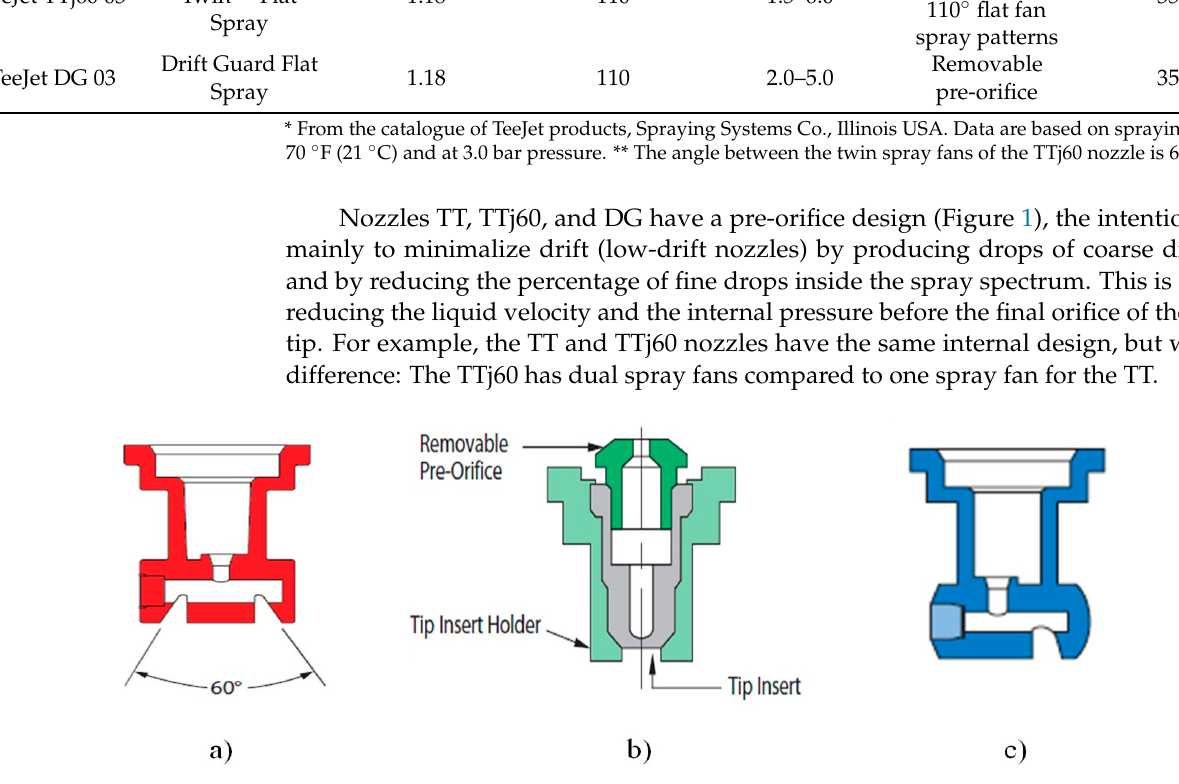
Figure 1. Cross-section view of the tested nozzles: ( a ) TTj60, ( b ) DG, ( c ) TT (TeeJet products, Spray- ing Systems Co., Illinois USA). Systems Co., Illinois